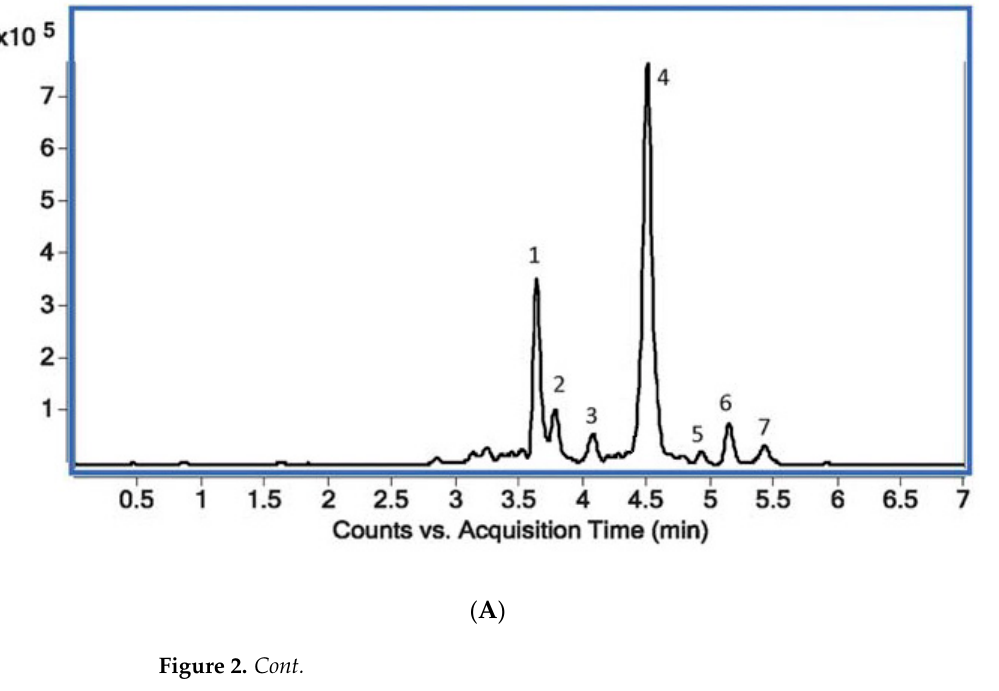
Table 1. Values of retention time (t R ), asymmetry factor (A S ), and theoretical plate number per meter (N/m) obtained for alkaloid standards.